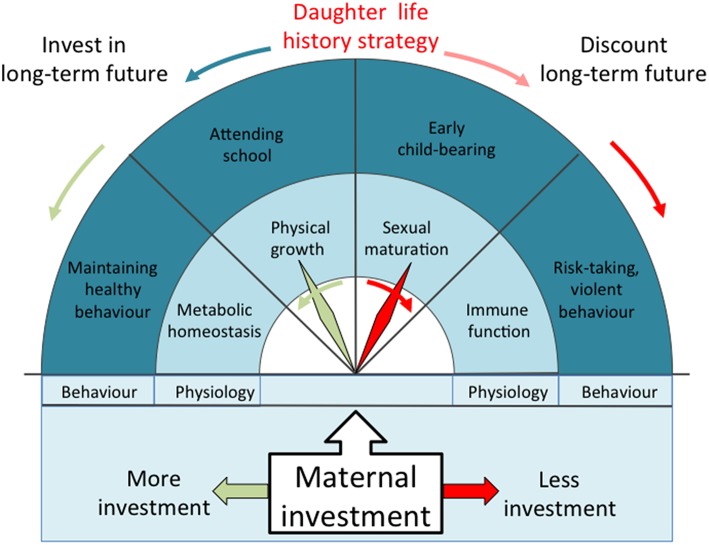
Schematic diagram illustrating our theoretical model derived from life history theory. The greater the magnitude of maternal investment during early life, the higher the phenotypic quality of the offspring and the greater the expected returns in the long-term future. Offspring fitness would then be maximized by investing in growth, maintaining health, acquiring education, and avoiding risky behavior, delaying reproduction until these other benefits have been realized. Lower maternal investment reduces the likely long-term returns, and favors earlier reproduction at a cost to competing traits. Central abdominal fat indicates greater allocation of energy to immune function, but at a cost to cardio-metabolic health.